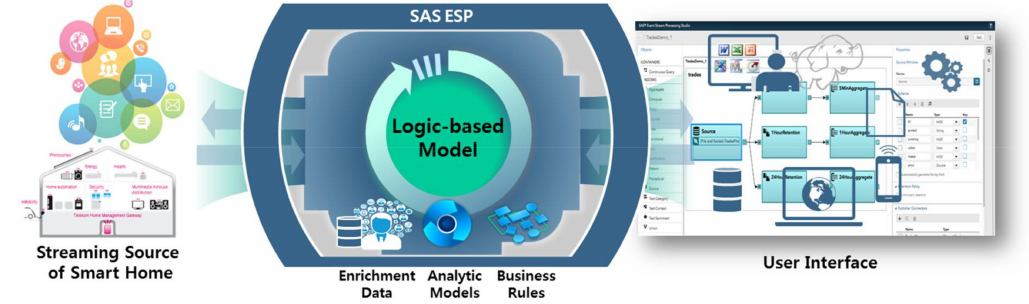
Figure 8. Connection to the user interface system by SAS